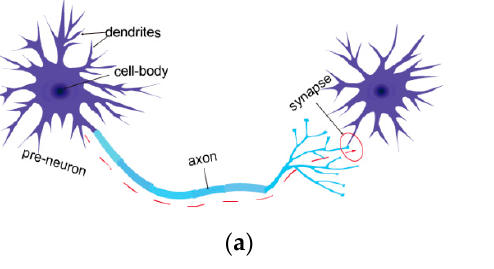
Figure 2. Analogy between biological neuron and skyrmion neuron: ( a ) a biological pre-neuron; ( b ) skyrmion-based LIF neuron [29].